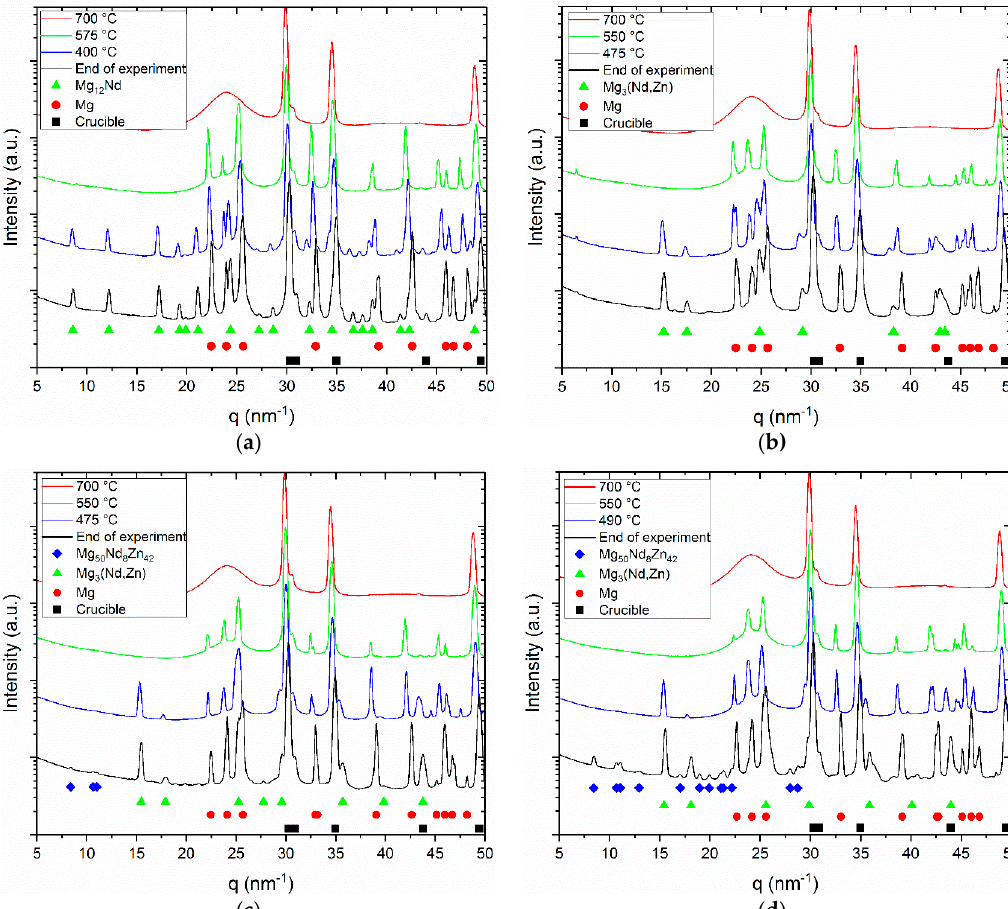
Figure 3. Line profiles obtained by the azimuthal integration of the diffraction patterns acquired during the in situ solidification experiments with 50 K/min cooling of ( a ) Mg-4Nd; ( b ) Mg-4Nd-3Zn; ( c ) Mg-4Nd-5Zn and ( d ) Mg-4Nd-8Zn.